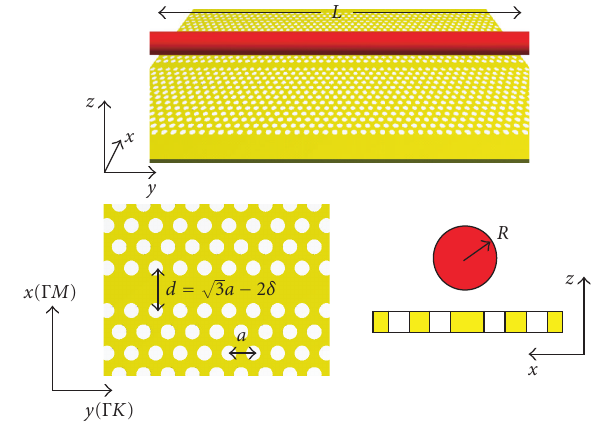
Figure 1: Schematic of SiO 2 -Wr and PSCW directional